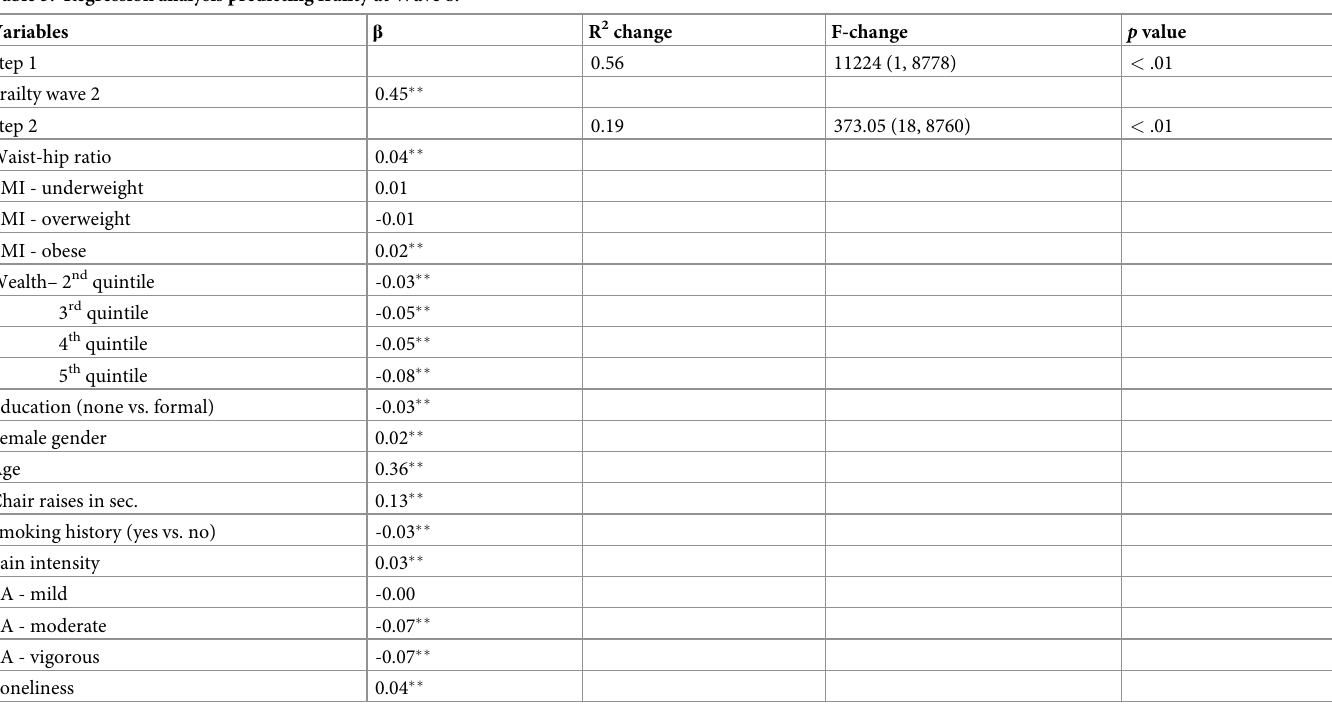
Table 3. Regression analysis predicting frailty at Wave